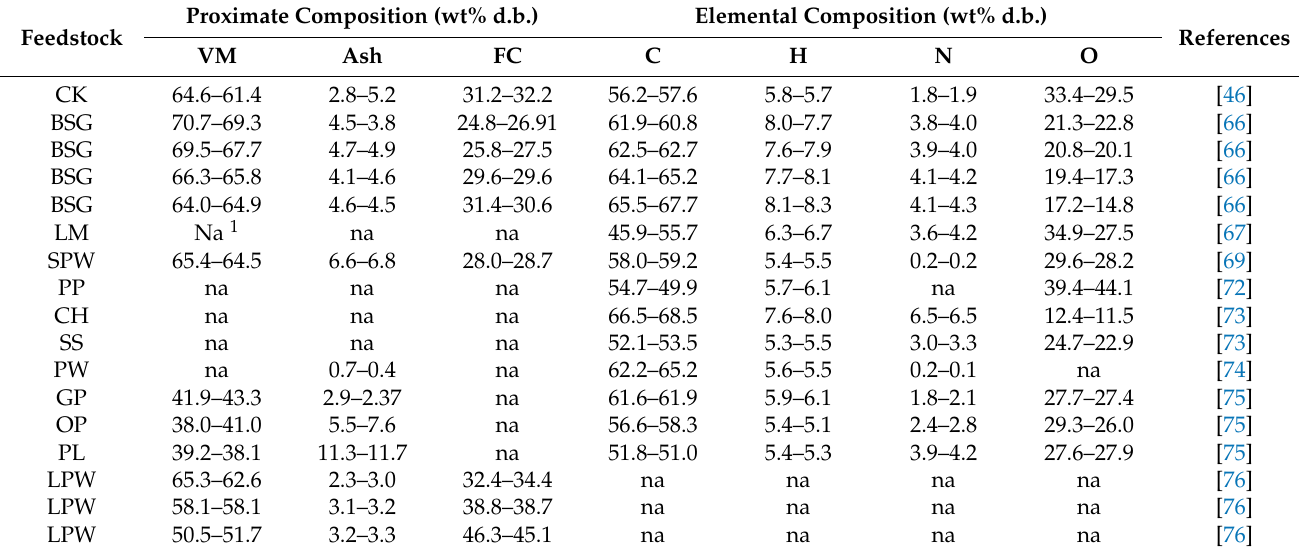
Table 2. Effect of process water recirculation on hydrochars’ proximate and elemental composition. For each parameter, reference value of HTC step with deionized water and value of recirculation step corresponding to maximum C (FC) content are reported. Operating conditions (temperature, RT, B/W, RS) are reported in Table 1.